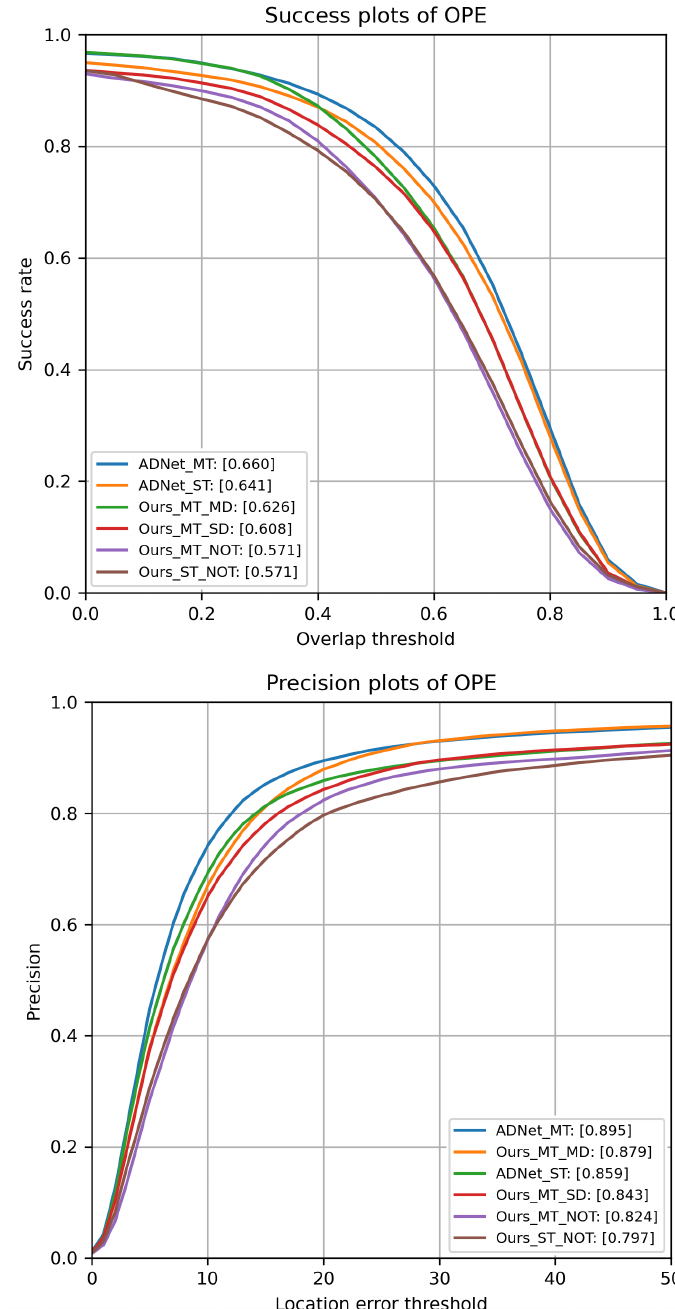
Figure 5. Success and Precision plots on OTB-100 (One-Pass Evaluation (OPE)). Overlap threshold and location error threshold indicate the threshold values used to compute the ROC curves. For the precision plot, the scores in the legend indicate the mean precisions when the location error threshold is 20 pixels. For the success plot, the scores indicate the area under curve